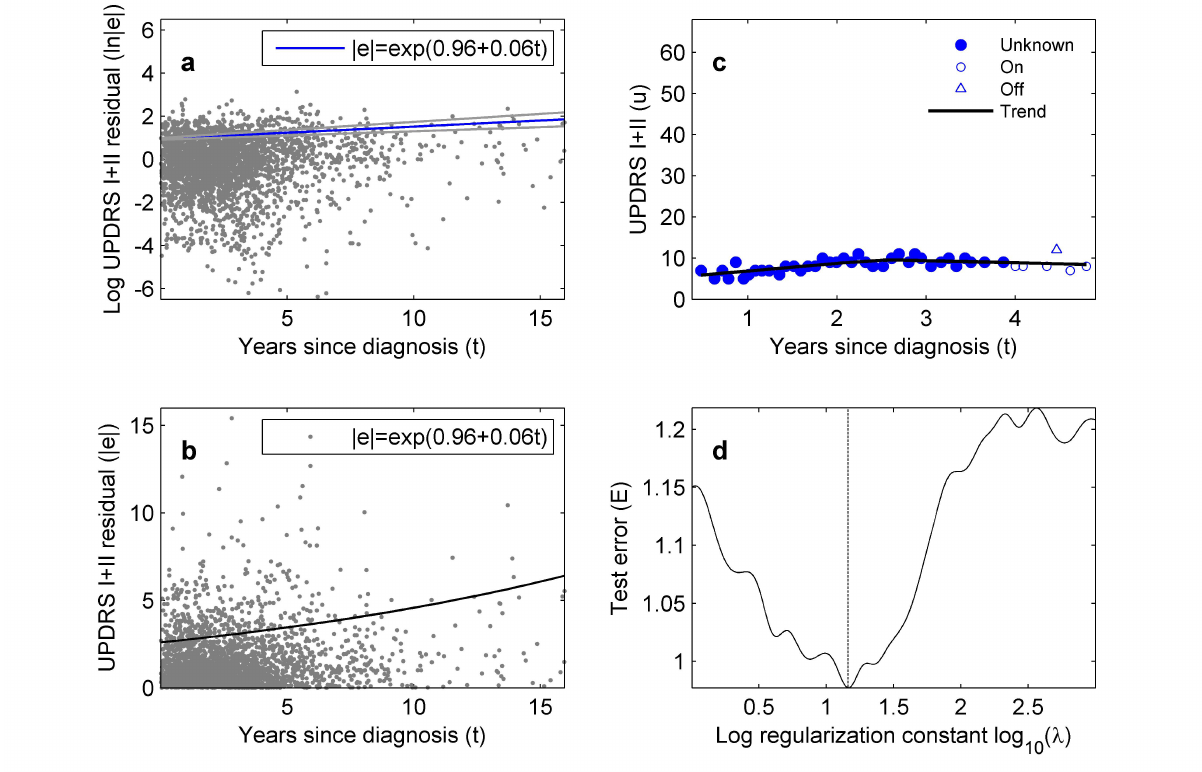
Figure 2. Trend fitting and residual modeling of the self-reported Unified Parkinson’s Disease Rating Scale (UPDRS) values (Parts I and II) in the PatientsLikeMe (PLM) dataset. (a) Absolute values of residuals obtained by subtracting the long- to medium-term trend from the raw values (natural logarithmic vertical scale), plotted against time since diagnosis in years. The blue line (formula inset) shows the estimated most-likely relationship between time since diagnosis and average absolute residual value. The gray lines are the 95% CI for the relationship; (b) the relationship between average absolute residual and time since diagnosis in (a) shown on a linear vertical scale; (c) UPDRS trend, used to calculate residuals, estimated from an example patient; (d) choice of trend regularization constant for (c), occurring at the smallest value of the cross-validated trend test